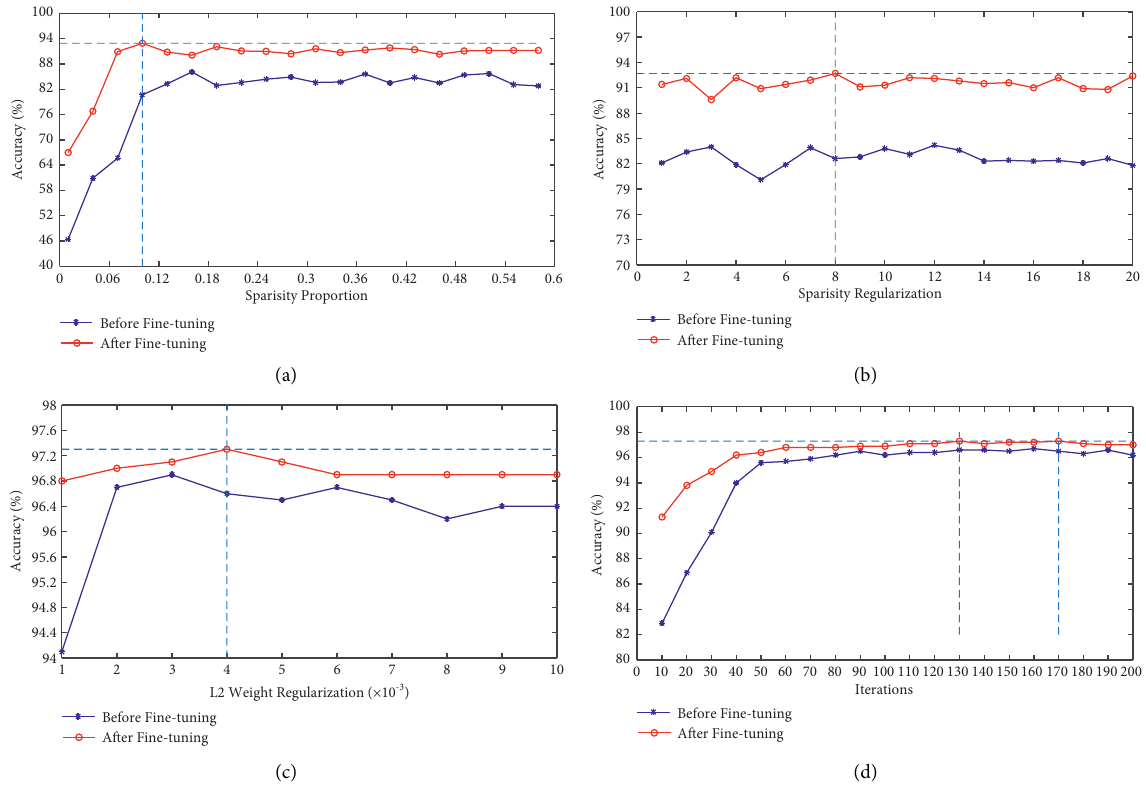
Figure 10: The relationship between different parameters and the accuracy of SSAE. (a) The influence of sparsity proportion on model accuracy. (b) The influence of sparse regularization on model accuracy. (c) The influence of L2 weight regularization on model accuracy. (d) The influence of iterations on model accuracy. The blue and red curves are the curves before and after fine tuning,